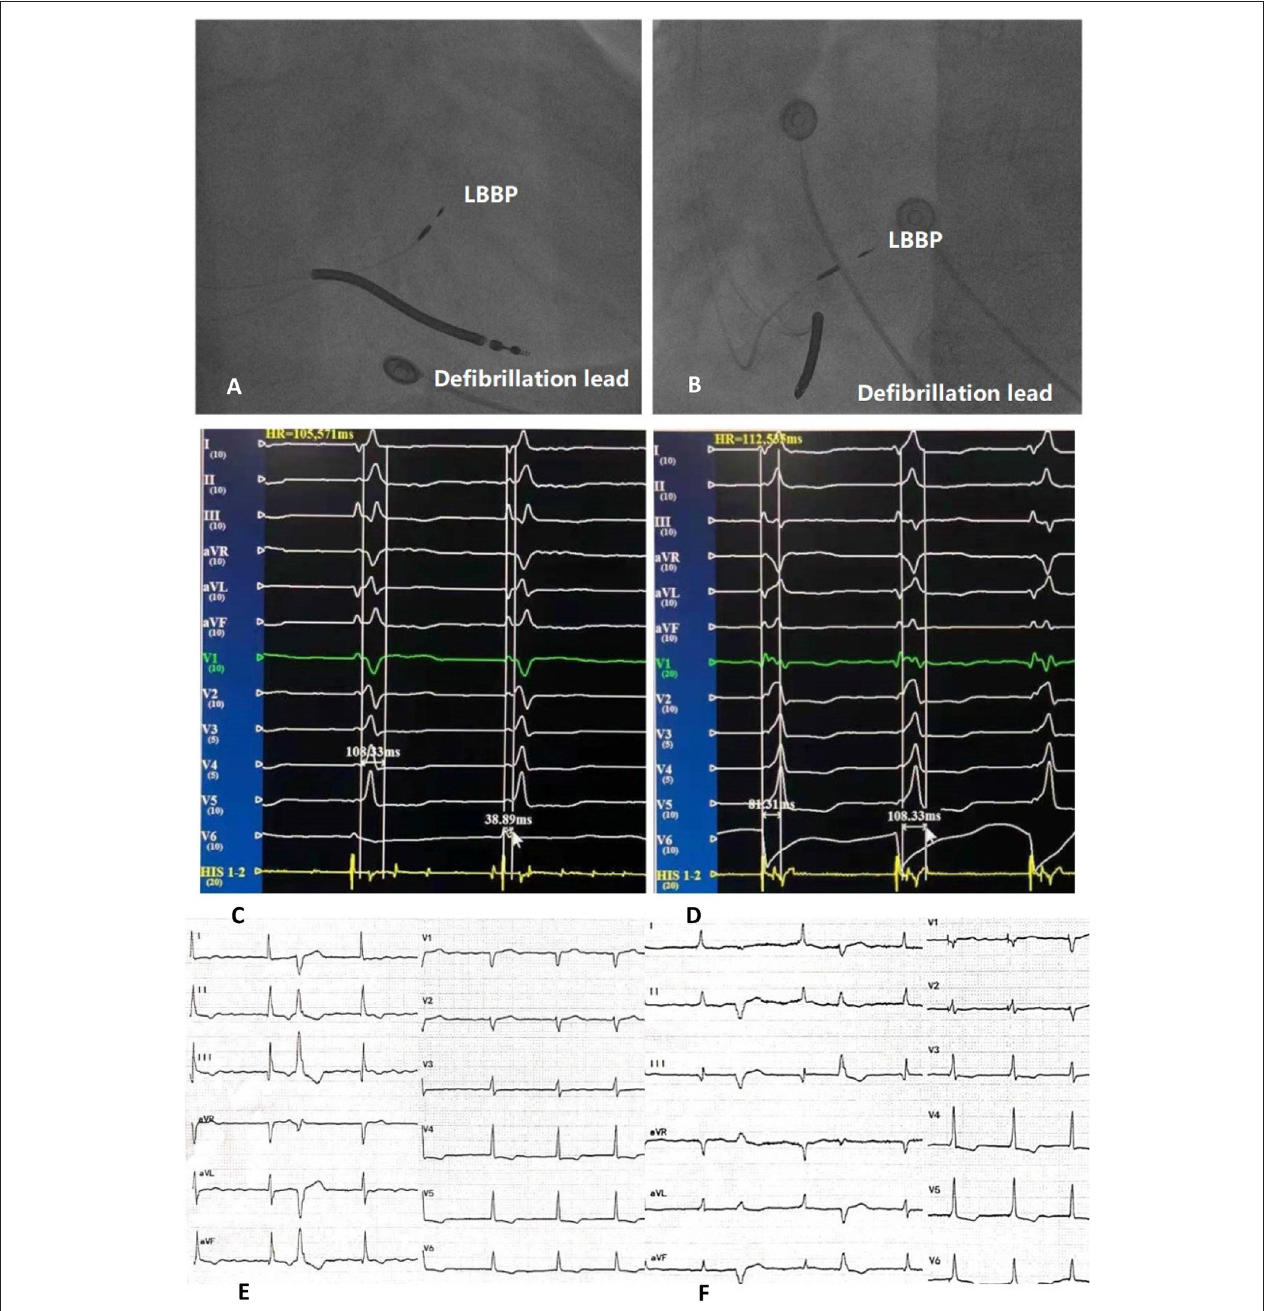
FIGURE 2 | Right anterior oblique fluoroscopic projections showing location of LBBP lead and defibrillation lead (A) . Left anterior oblique fluoroscopic projections showing location of LBBP lead and defibrillation lead (B) . Twelve-lead ECG and EGM from LBBP leads of intrinsic rhythm (C). Twelve-lead ECG and EGM from LBBP leads of LBBP and LVAT (D) . Bedside twelve-lead ECG of intrinsic rhythm (E) . Bedside twelve-lead ECG of LBBP (F) . LBBP, left bundle branch pacing; ECG, electrocardiogram; EGM, electrogram; LVAT, peak left ventricular activation